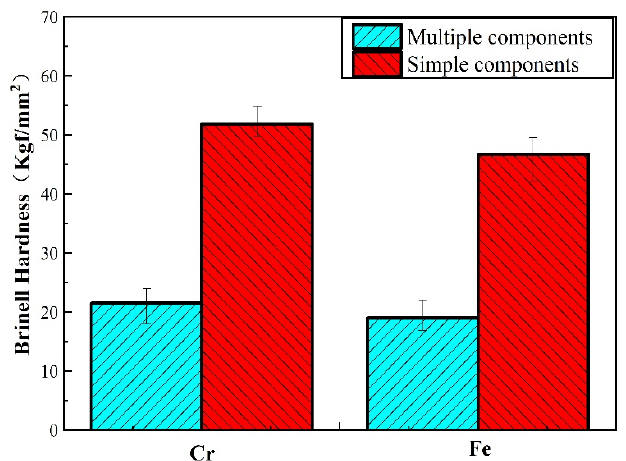
Figure 7. Brinell hardness of Cu–BCs.